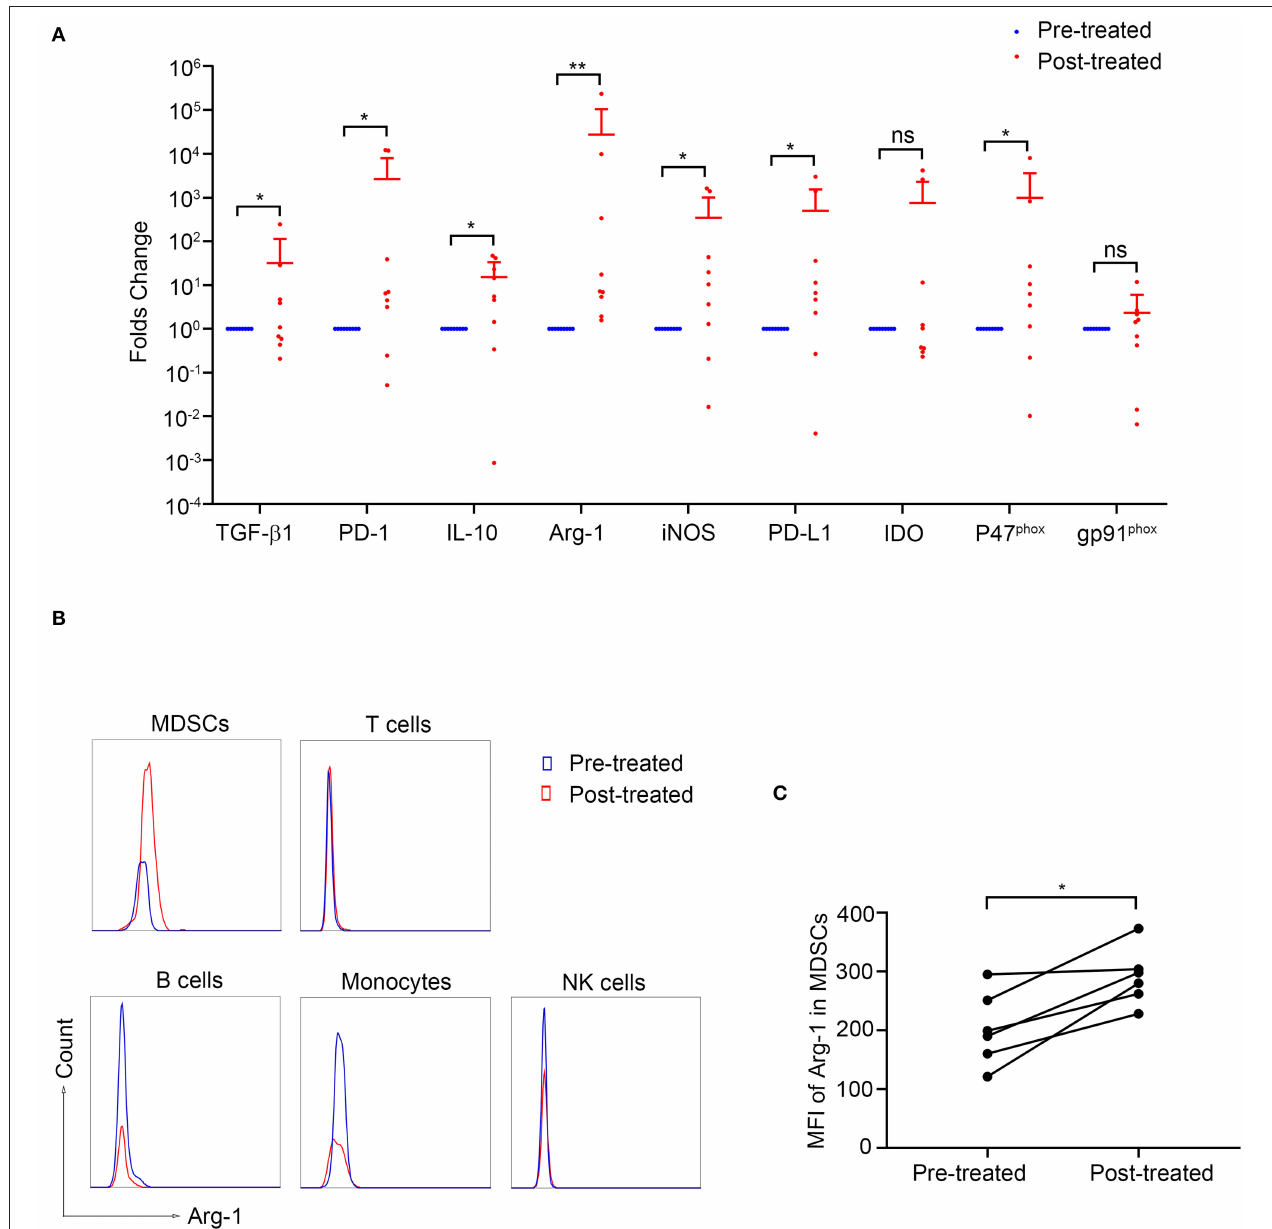
FIGURE 5 | Arginase-1 expression in patients with MG before and after immunotherapy. (A) The expression of MDSC-related molecules was measured by qPCR ( n = 9). * p < 0.05, ** p < 0.01. (B) Representative flow cytometry analysis of Arg-1 MFI in PBMC subpopulations from pre-treated and post-treated patients. Arg-1 MFI in MDSCs increased after immunotherapy ( n = 6, C ). * p <